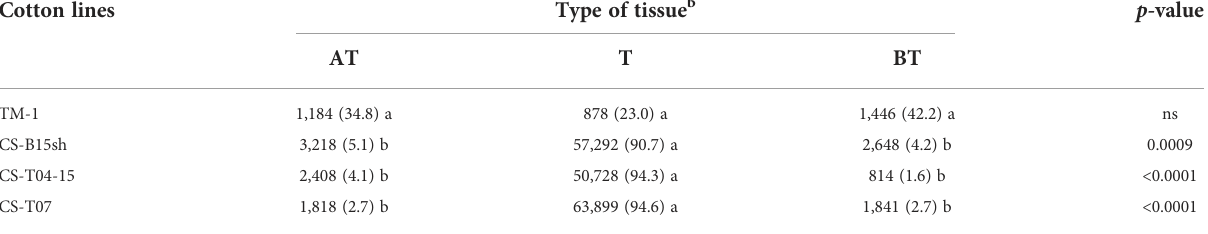
TABLE 1 Translocation of [ 14 C]2,4-D in the cotton accessions after 24 h of treatment a . Cotton lines